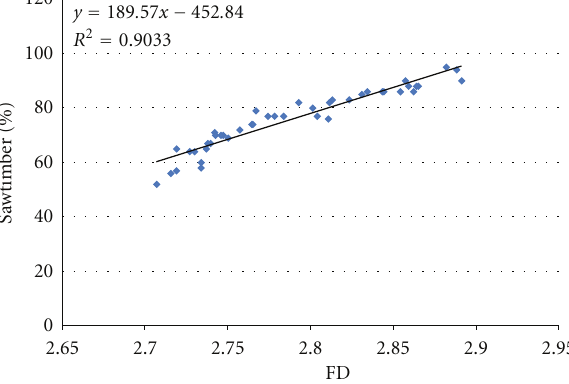
Figure 12: FD versus saplings (bounds